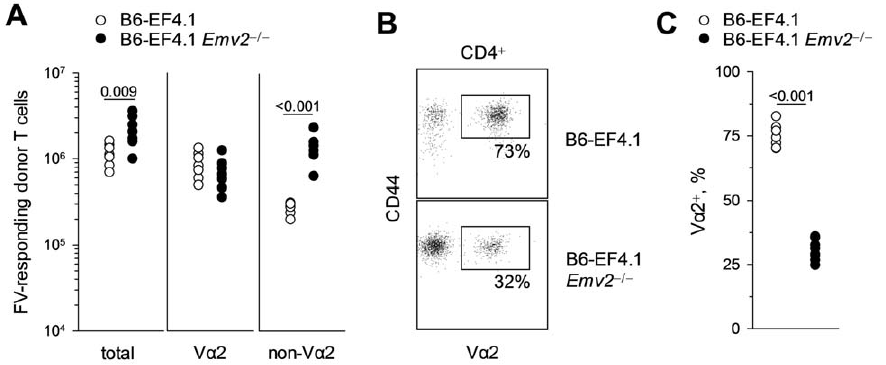
Figure 4. Emv2 -selected CD4 + T cells mount a predominantly high-avidity response. (A–C) CD45.2 + ( Ptprc 2/2 ) CD4 + T cells isolated from either B6 (B6-EF4.1) or Emv2 -deficient B6 (B6-EF4.1 Emv2 2 / 2 ) EF4.1 donor mice were adoptively transferred into Ptprc 1/2 B6 recipients that were infected with FV the same day and analyzed 7 days later. (A) Absolute number of total, V a 2 or non-V a 2 FV-responding (CD44 hi ) donor (CD45.2 + CD45.1 2 ) CD4 + T cells isolated from the spleens of recipient mice according to donor type. (B) Flow cytometric example and (C) frequency of high-avidity V a 2 cells in responding CD4 + T cells according to donor type. In (A) and (C) each symbol is an individual mouse.